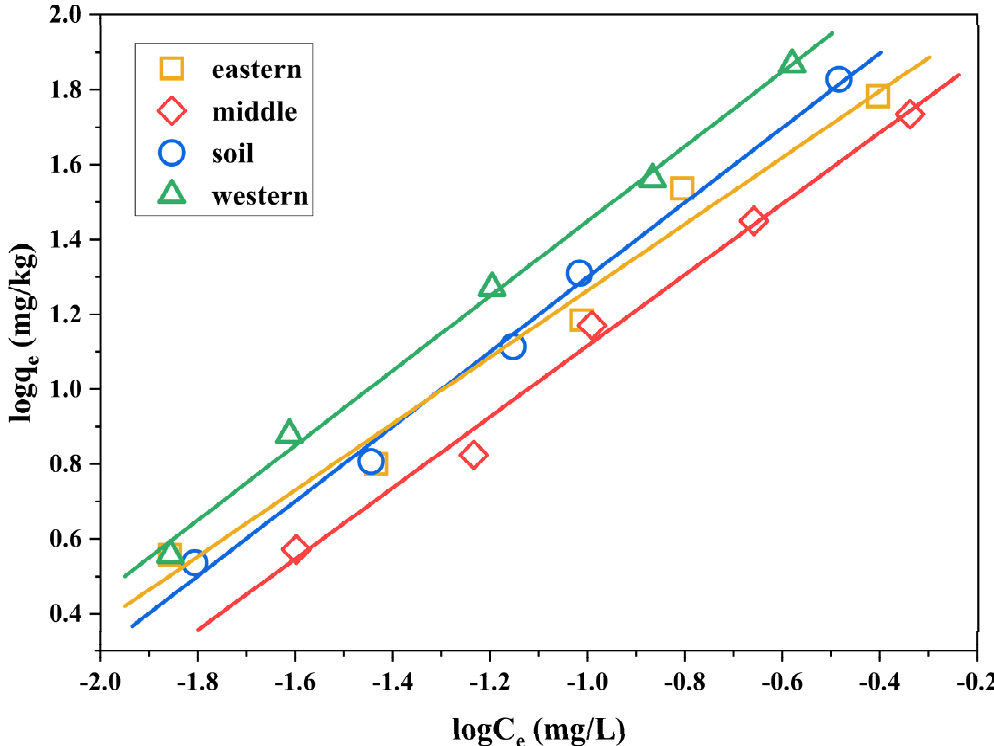
Figure 3. Freundlich sorption isotherms of 2,3,7,8-TCDT in three sediments from Chaohu Lake and paddy soil. Table 3. Freundlich model parameters of 2,3,7,8-TCDT in sediments and paddy